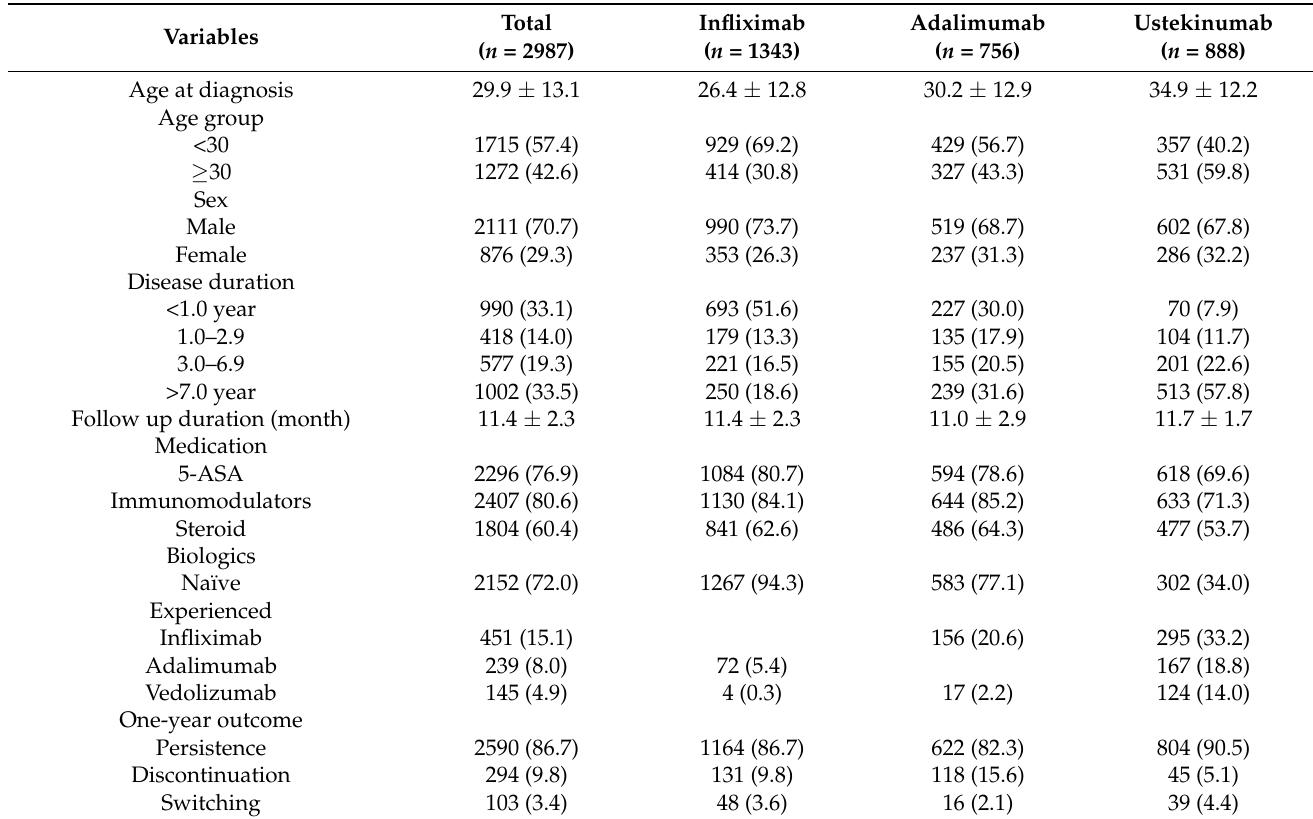
Table 1. Baseline characteristics of the study population, n